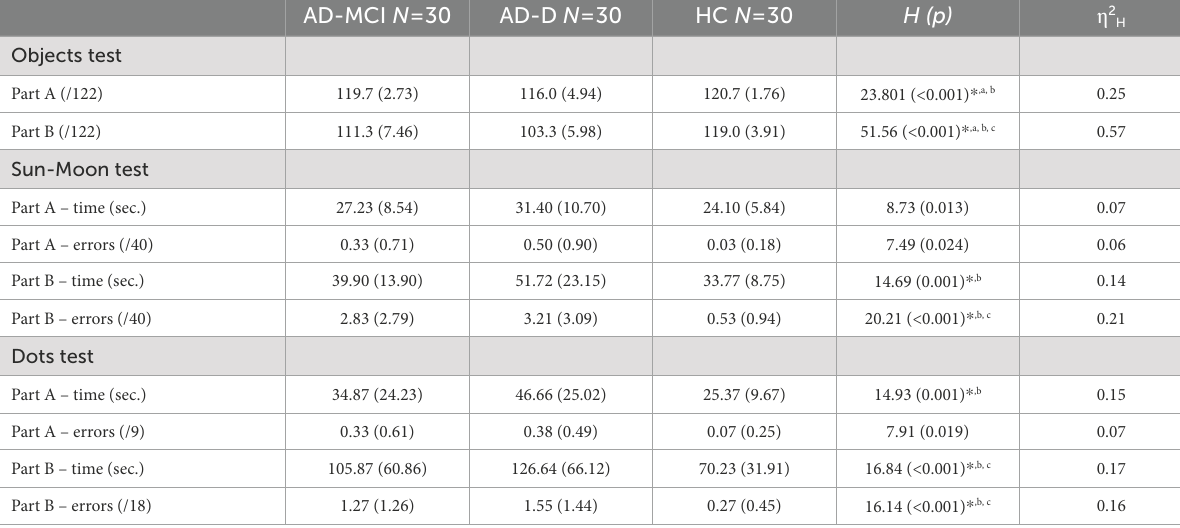
TABLE 2 Intergroup differences on CCD scores for AD and HC